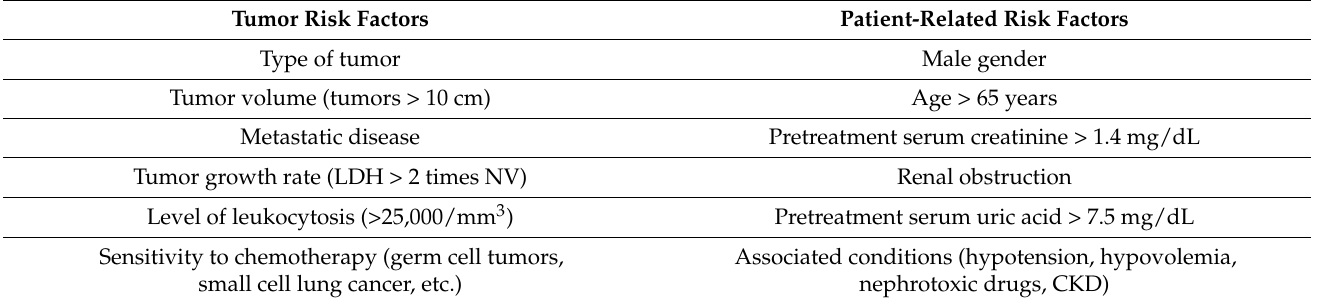
Table 3. Risk factors for tumor lysis syndrome